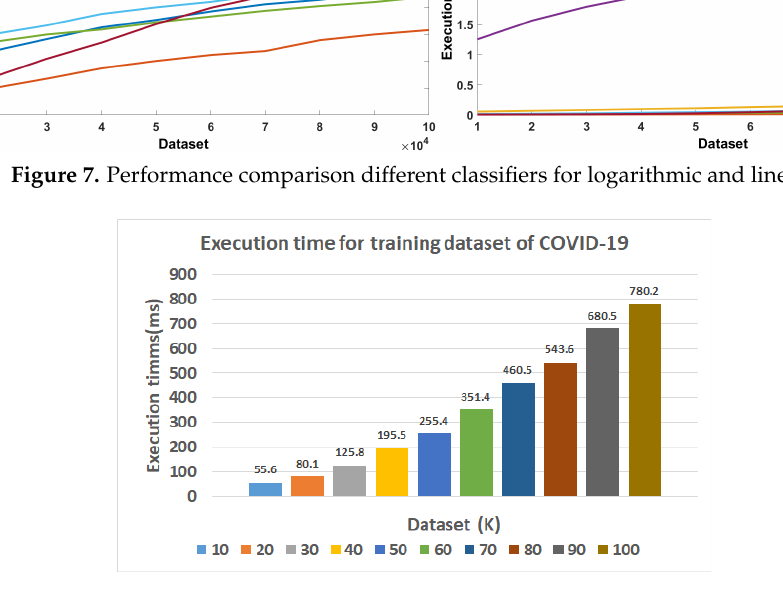
Figure 8. Performance validation (based on execution time) of our proposed TSODT